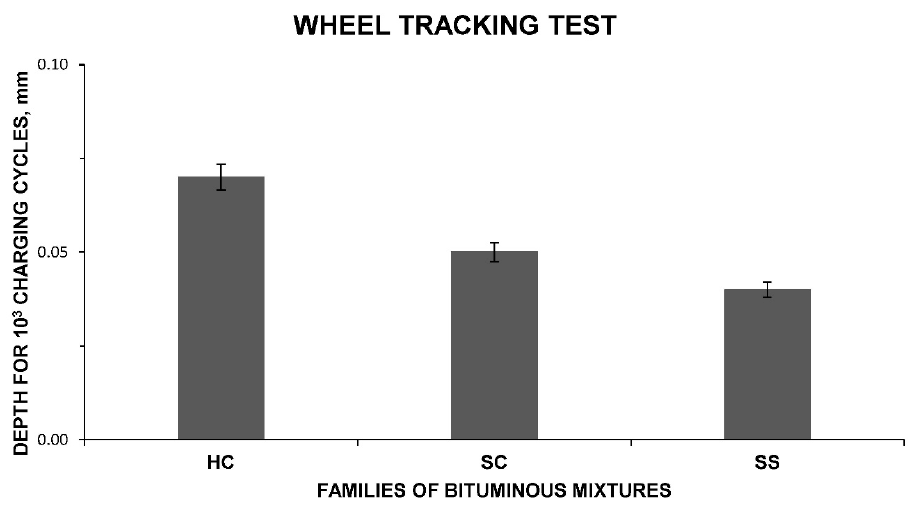
Figure 11. Wheel ‐ tracking test for the optimum combination of materials from the HC, SC, and SS families of bituminous Figure 11. Wheel-tracking test for the optimum combination of materials from the HC, SC, and SS mixtures. families of bituminous